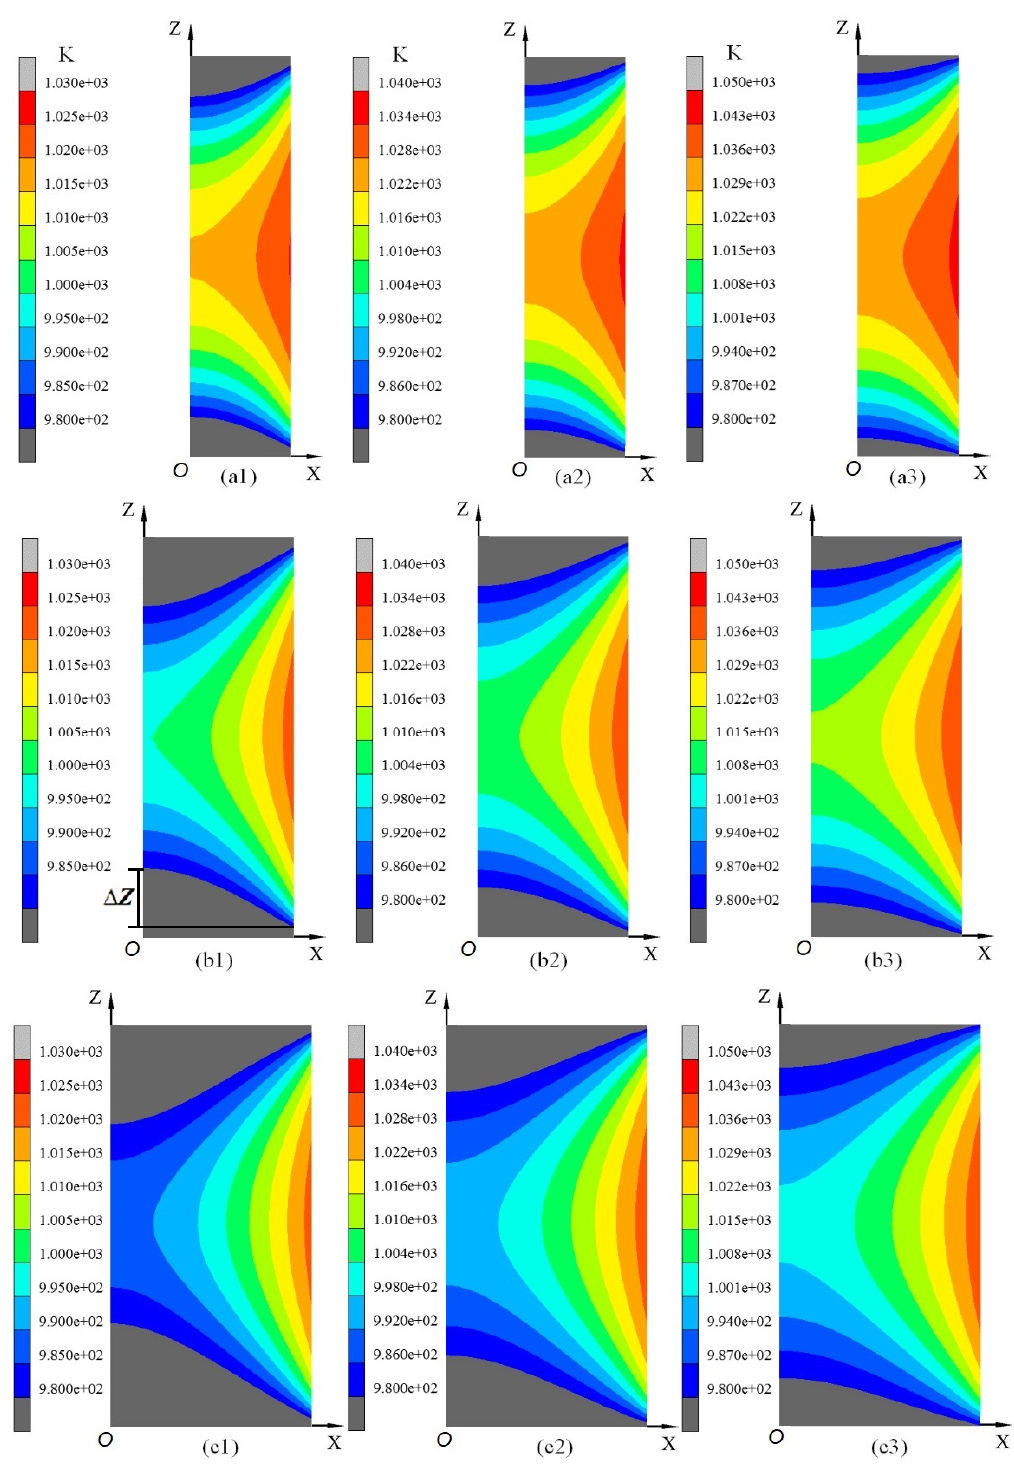
Figure 3. The temperature field when the melting zone was with 0.08–0.12 m away from the bottom of crucible. The unit of the temperature field is K, and the 980 K isotherm line was regarded as the solid–liquid interface. ( a1 ) crystal radius 0.01 m, the maximum furnace temperature 1030 K; ( a2 ) 0.01 m, 1040 K; ( a3 ) 0.01 m, 1050 K; ( b1 ) 0.015 m, 1030 K; ( b2 ) 0.015 m, 1040 K; ( b3 ) 0.015 m, 1050 K; ( c1 ) 0.02 m, 1030 K; ( c2 ) 0.02 m, 1040 K; ( c3 ) 0.02 m, 1050